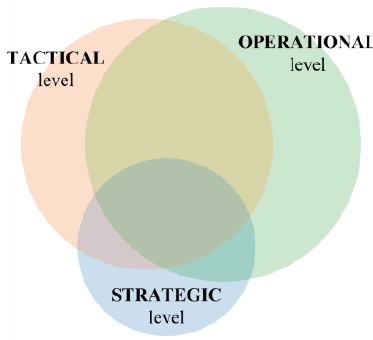
Figure 2. BIM/GIS Integration : Asset Management functions. Functions are described in Re Cecconi et al.